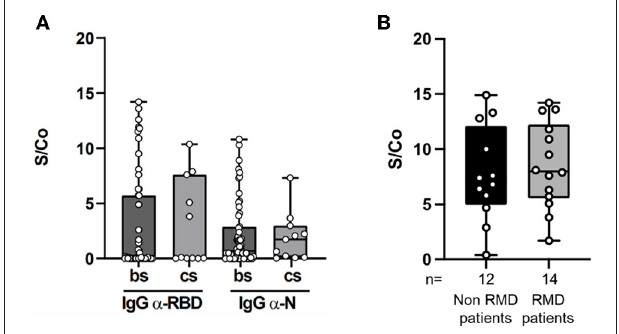
FIGURE 1 | Magnitude of the anti-RBD and anti-N antibody response in RMD patients. (A) IgG levels against SARS-CoV-2 RBD (left panel) and N (right panel), expressed as Signal (S) vs. Control (Co) measured by ELISA in sera of RMD patients treated with b/ts-DMARD and cs-DMARD. (B) IgG levels against SARS-CoV-2 RBD in sera of RMD patients treated with b/ts-DMARD and cs-DMARD and in non-RMD patients not under 290 immunosuppressant treatment and RMD patients undergoing b/ts- or cs-DMARD treatment. Each dot into the box represent individual values, and bar min and max values. Statistical analyses were performed using Mann-Whitney t -test to compare two